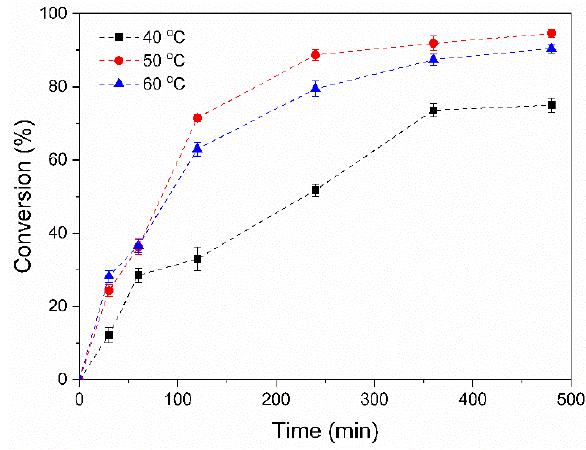
Figure 2. Effect of temperature on the monomer conversion of (PAA- co